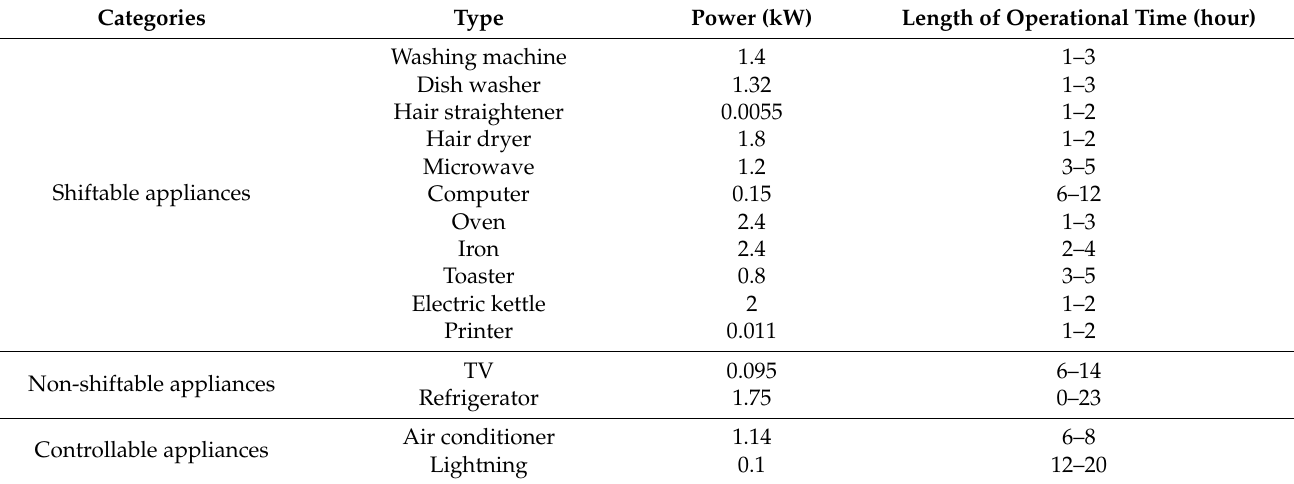
Table 4. Smart home appliance classification and parameters [48].